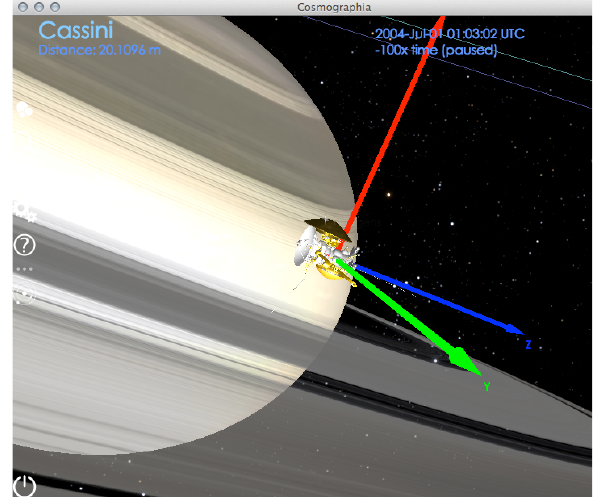
Figure 3 A snapshot taken from SPICE-Enhanced Cosmographia, showing the Cassini spacecraft near Saturn Rather than try to list here all of its many features, the reader is referred to the SPICE-enhanced Cosmographia on-line User's Guide, found here: http://cosmoguide.org/. More information and download instructions may be found here: